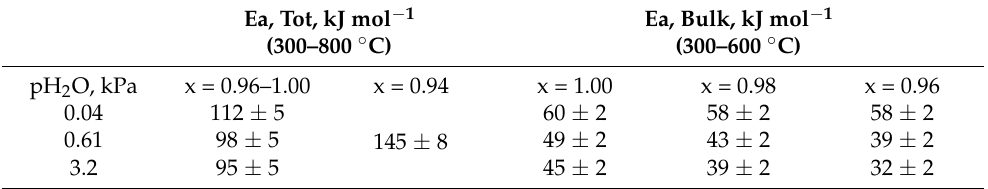
Table 1. Activation energies of the total and bulk conductivities of Sr x Zr 0.95 Yb 0.05 O 3- δ .